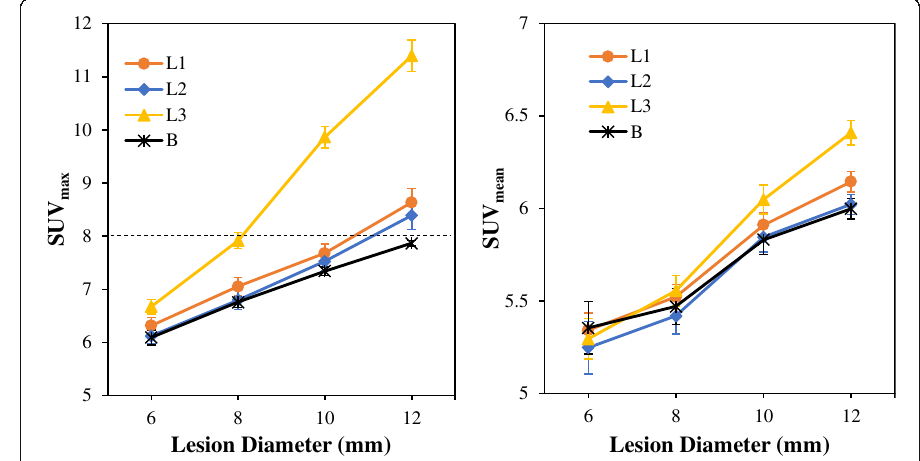
Fig. 5 The spill-in and spill-out effects as a function of lesion size for lesions L1 – L3 and background lesion B at bladder SUV 55.5. The SUVs were obtained from OSEM reconstructed images using the mean SUVs of all noise realisations at 30 full iterations with a 4-mm Gaussian post-filter. The error bars are the standard error of the mean (SEM) while the dashed horizontal line denotes the true simulated lesion SUV. Background lesion B is the reference which shows the expected lesion SUV without spill-in